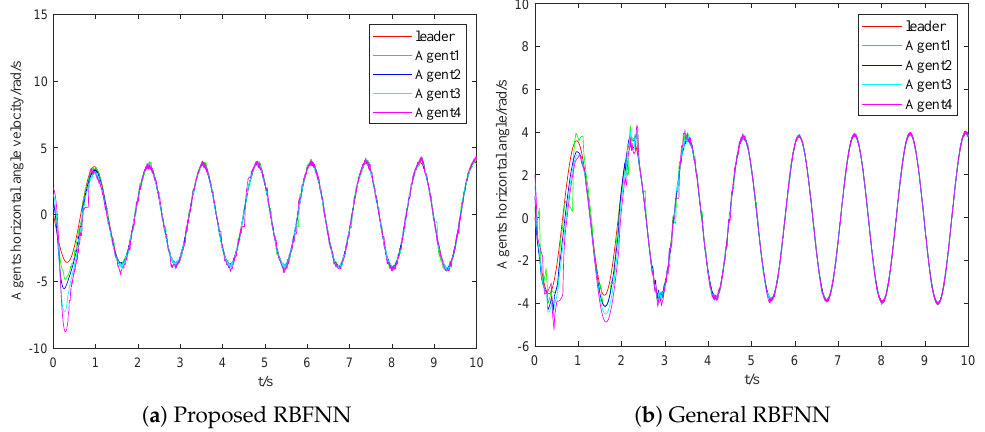
Figure 4. The comparison of response curves for horizontal angular velocity.